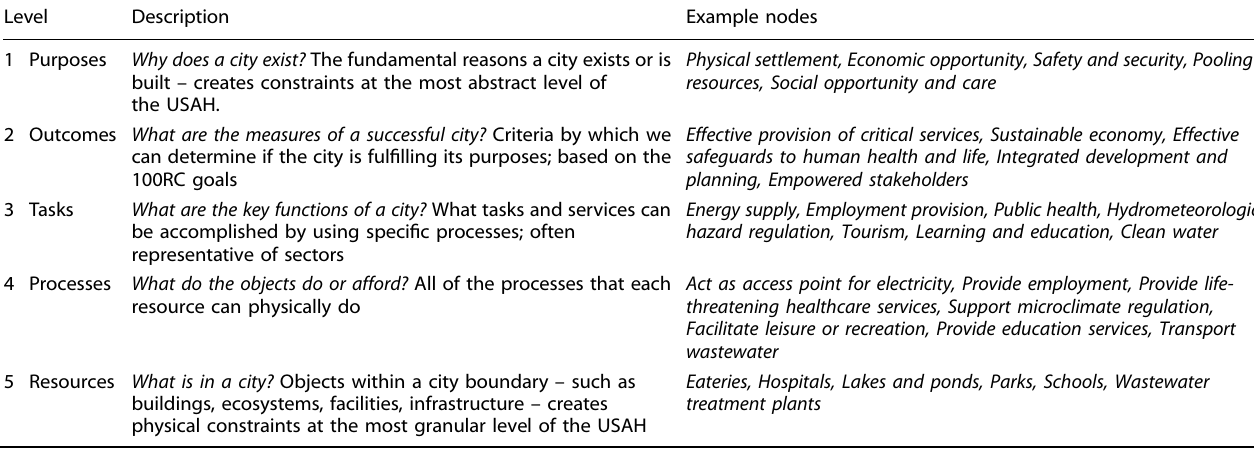
Table 1. Example nodes for each USAH